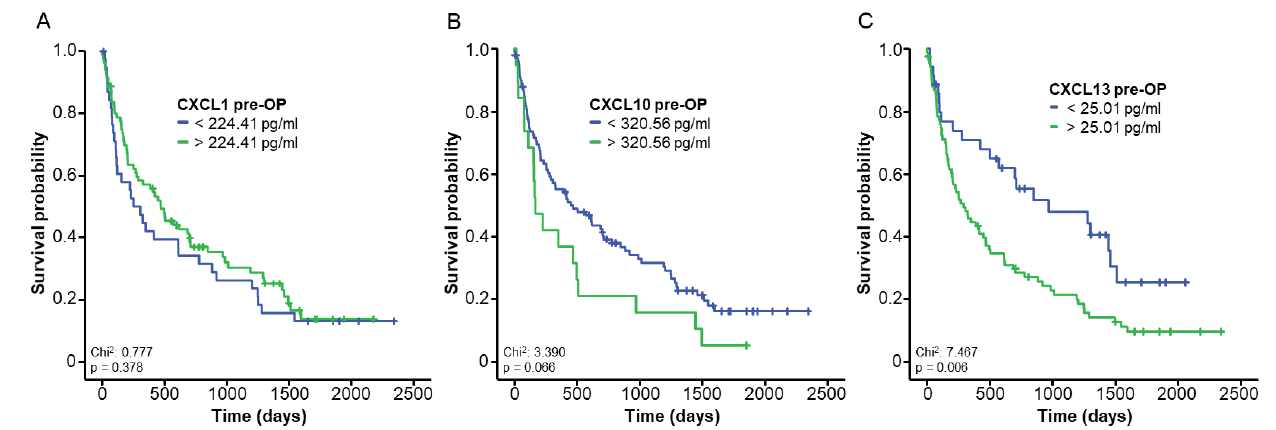
Figure 2. Elevated baseline levels of CXCL13 indicate poor overall survival after BTC resection. ( A – C ) Overall survival in BTC patients with initial CXCL1, CXCL10 and CXCL13 levels above or below the ideal prognostic cut-off value. Table 2. Uni- and multivariate Cox regression analyses of preoperative parameters for the prediction of overall survival. Univariate Cox Regression Multivariate Cox